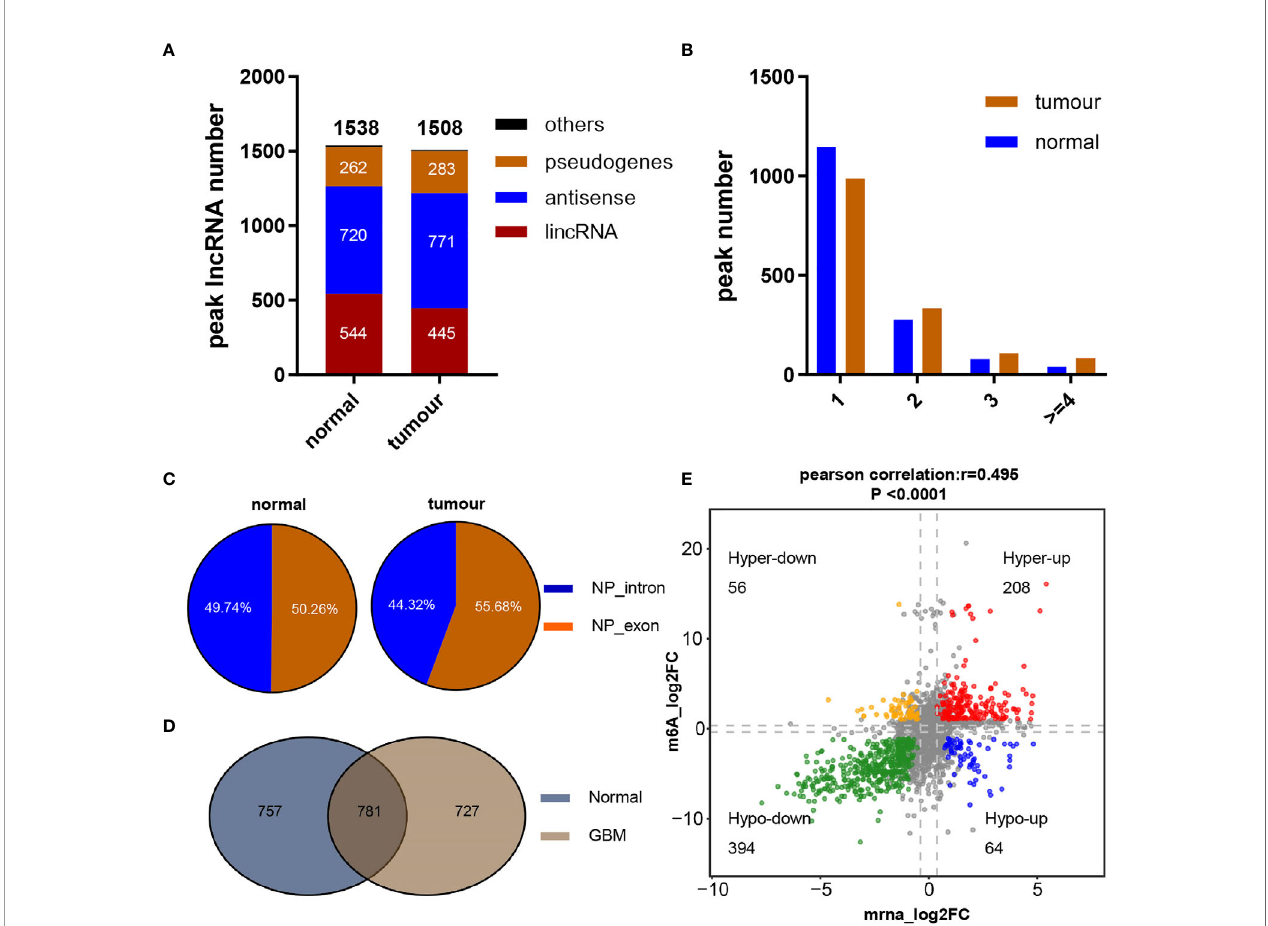
FIGURE 1 | Overview of m 6 A methylation within lncRNAs in GBM and normal brain tissues. (A) Numbers and gene types of lncRNAs identi fi ed in normal brain and GBM tissue samples as identi fi ed by m 6 A-seq. (B) The number of m 6 A-modi fi ed peaks per lncRNA transcript. (C) Distribution of m 6 A peaks across lncRNA transcripts. (D) Numbers of common and tissue-speci fi c m 6 A lncRNAs in normal and GBM brain tissues. (E) Dot plot of Log2FC (lncRNA expression) versus Log2FC (differential m 6 A methylation) values showing a positive correlation between the overall m 6 A methylation level and the lncRNA expression level (Pearson ’ s r = 0.495; P < 0.0001) and the distribution of genes with signi fi cant changes in both the m 6 A (FC ≥ 1.2, P ≤ 0.05) and corresponding lncRNA expression levels in GBM samples compared with normal brain tissues (FC ≥ 2, padj ≤